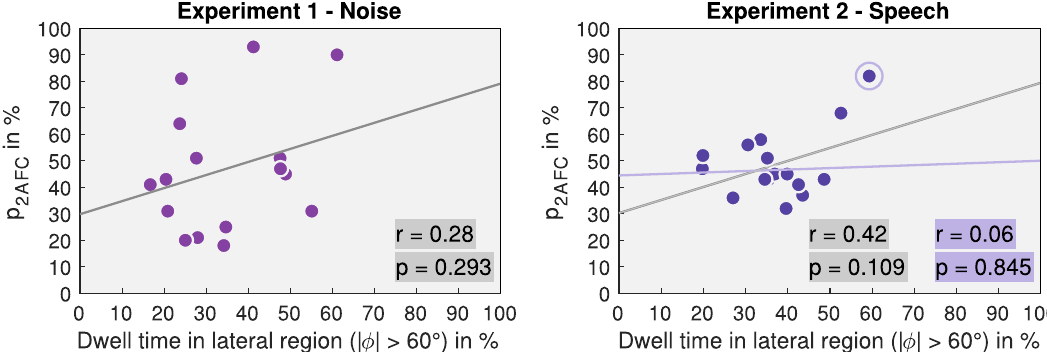
Figure 5. Participants ’ dwell time in lateral region (| / | > 60 (cid:3) ) vs. their percentage of correct answers p 2 AFC for Experiment 1 (left) and Experiment 2 (right). The solid line is the least-squares line of best fi t. The right plot shows in purple the results of the correlation analysis for Experiment 2, excluding the outlier (data point circled in